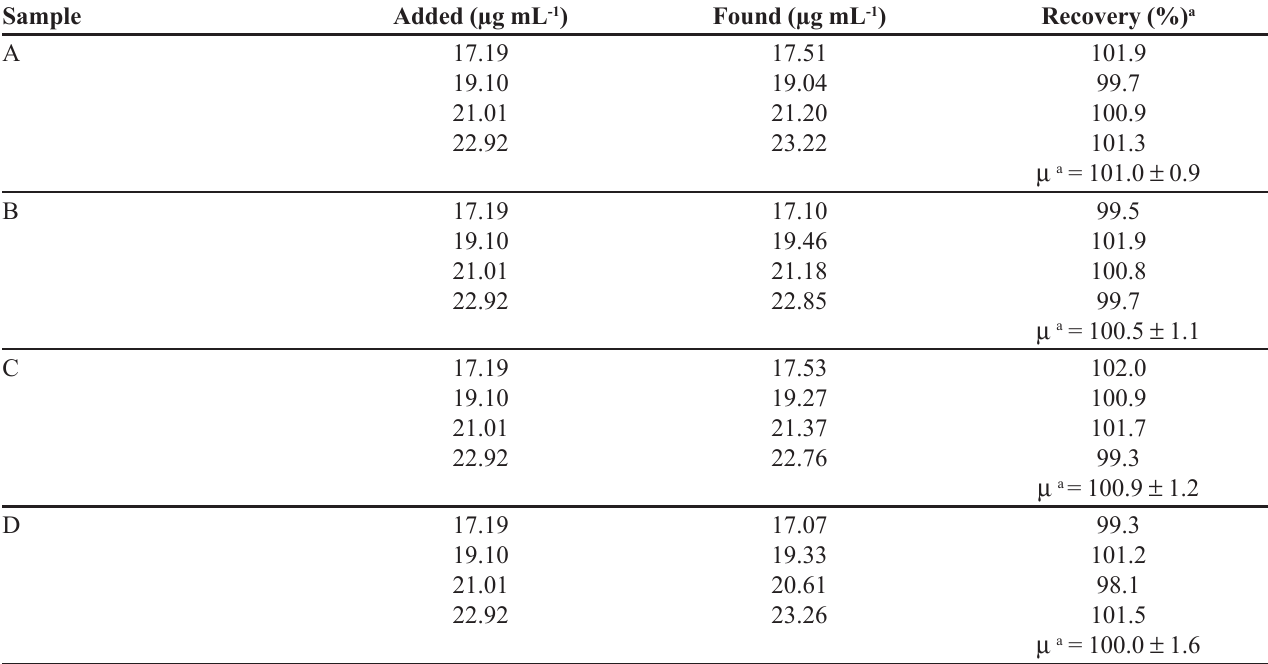
TABLE IV - Recovery/accuracy data of the proposed method for the pharmaceutical formulations spiked with four different concentrations of